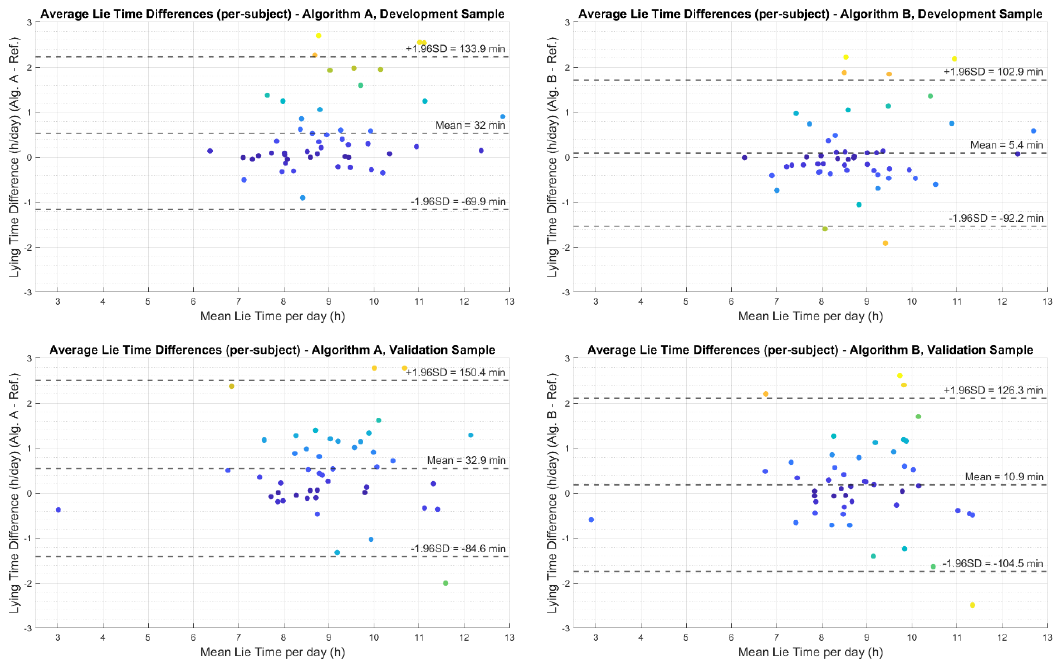
Figure 5. Bland Altman plots showing the difference in estimation of average lying down time per participant between the reference method and the two algorithms A and B. Each dot in the plots represent a participant. The mean value of lying time by the reference method and each algorithm is given in x -axes. The difference between lying time detected by each algorithm and the reference method is given in y -axes. There were no correlations between the difference in detected time by Algorithm B and the reference method and the participants height (𝑟 = −0.25) , BMI (𝑟 = −0.07) , KOOS-pain (𝑟 = −0.01) , or KOOS-ADL (𝑟 = 0.02) . Out of the 18 days, that corresponded to the days with the 5% highest difference be- tween lying down time according to Algorithm B and the reference, 13 days were derived from unique participants. In 17 of these days the major differences in classifications oc- curred in daytime during leisure, defined from the participants work diary. 4. Discussion In this study, we developed two non-proprietary algorithms (A and B) aimed at de- tecting lying down time from raw tri-axial accelerometric data of a single thigh worn ac- celerometer. Algorithm A was a direct implementation of an earlier presented method by Lyden et al. The difference between Algorithm A and the Lyden method is that the Lyden method is based on definitions of sedentary bouts from the proprietary ActivePAL soft- ware [10] and Algorithm A is based on the validated and open Acti4 algorithm [4,15,16]. Algorithm A was then further refined into Algorithm B to handle some known issues with misclassifications. The performance of both A and B algorithms to identify lying down time was compared against a reference method including both thigh and back accelerom- eters to identify lying down time during free living conditions.